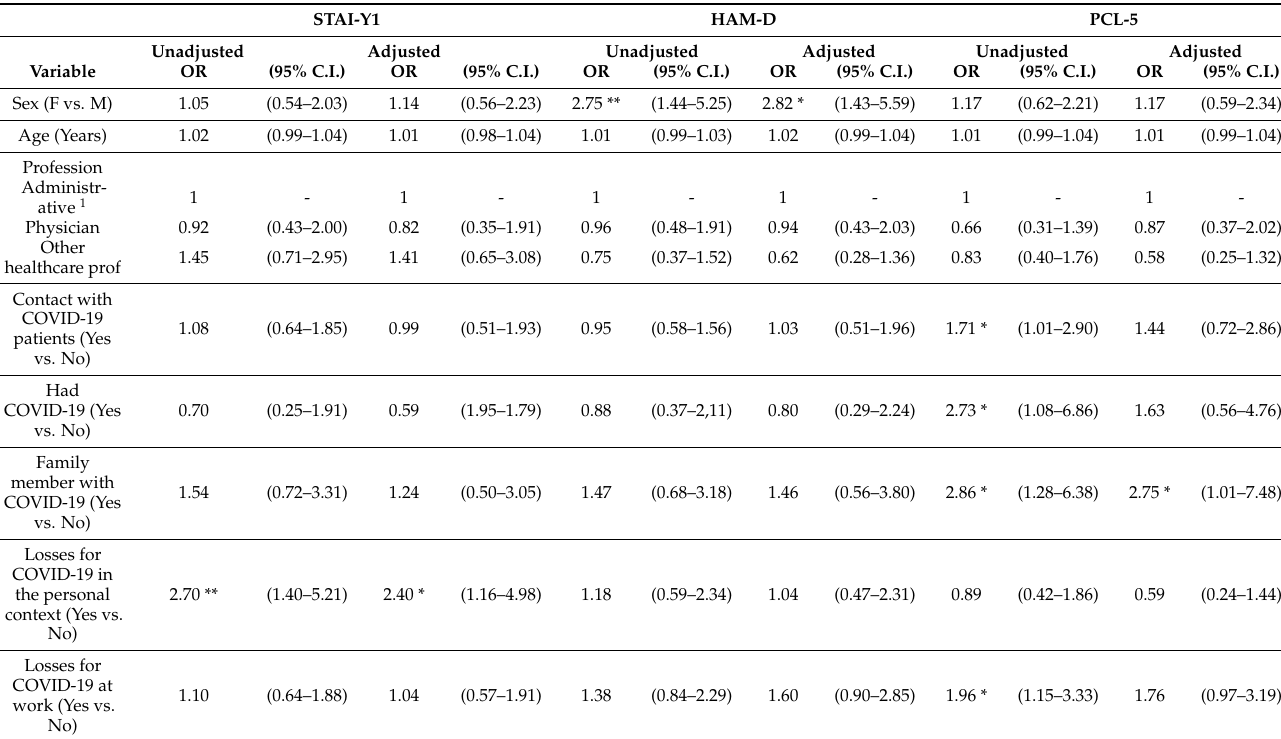
Table 3. Association of sex, age, profession and COVID-19 experience with anxiety (STAI-Y1), depression (HAM-D) and post-traumatic stress disorder